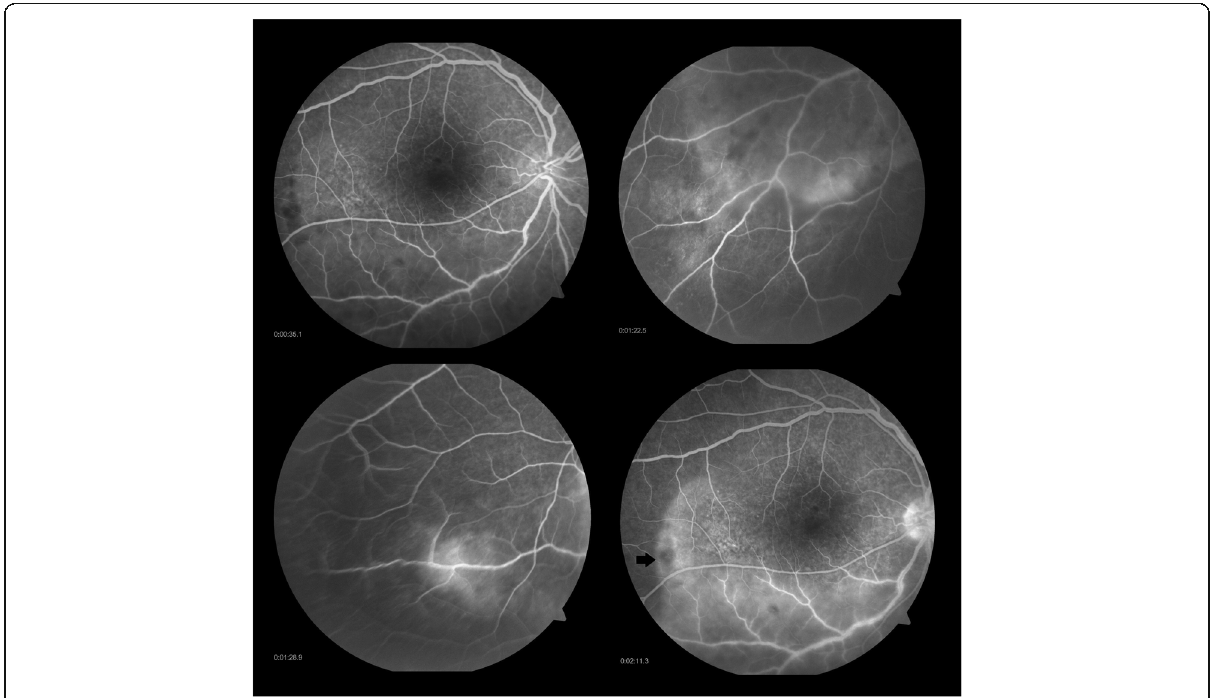
Fig. 3 Fundus fluorescein angiography of the right eye showing a hot disc with a hyperfluorescent edge of the posterior placoid retinochoroiditis lesion (black